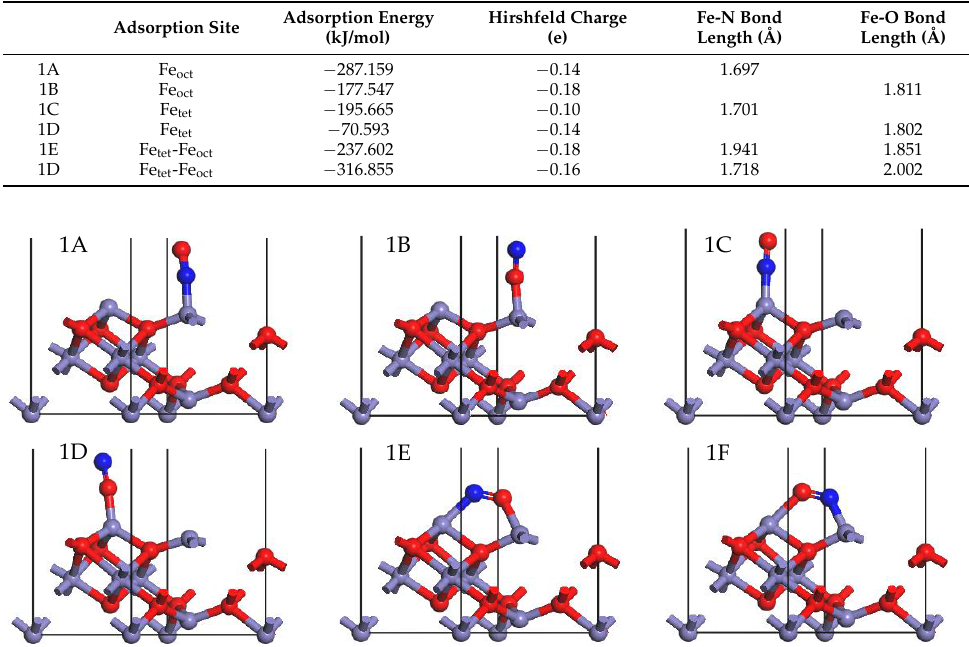
Figure 3. Stable adsorption configurations of NO on the γ -Fe 2 O 3 (111) surface (N, blue; Fe, purple; O, red). Table 2. The parameters of optimized configurations of the γ -Fe 2 O 3 (111) surface-adsorbed NO mol- ecule.